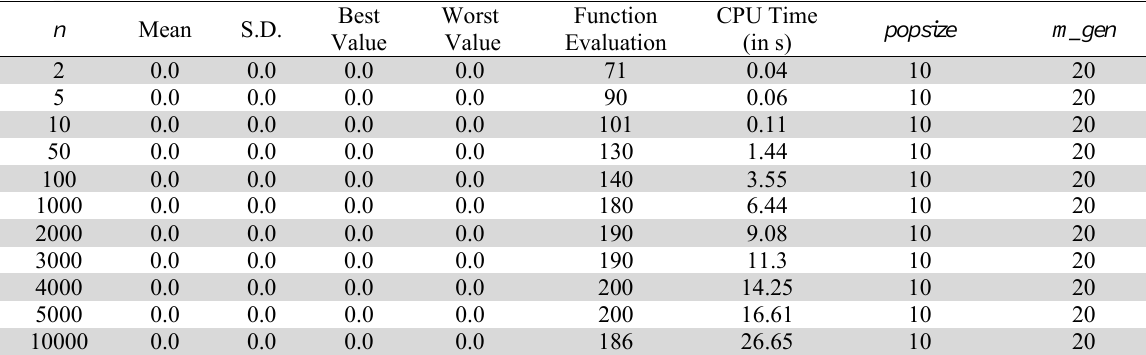
Computational Results of Problem -9